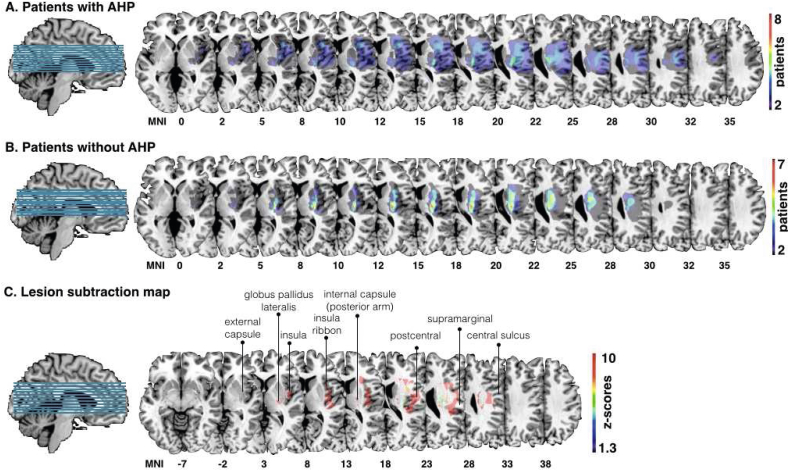
Group-level lesion overlay maps for patients with anosognosia for hemiplegia (AHP) and controls. A. Overlay of lesions in patients with anosognosia (AHP; n = 8); B. Overlay of patients without anosognosia (n = 7). C. Statistical analysis comparing the two populations of patients (AHP present-AHP absent; results are corrected for multiple comparisons, p < .05 for Z > 1.3).